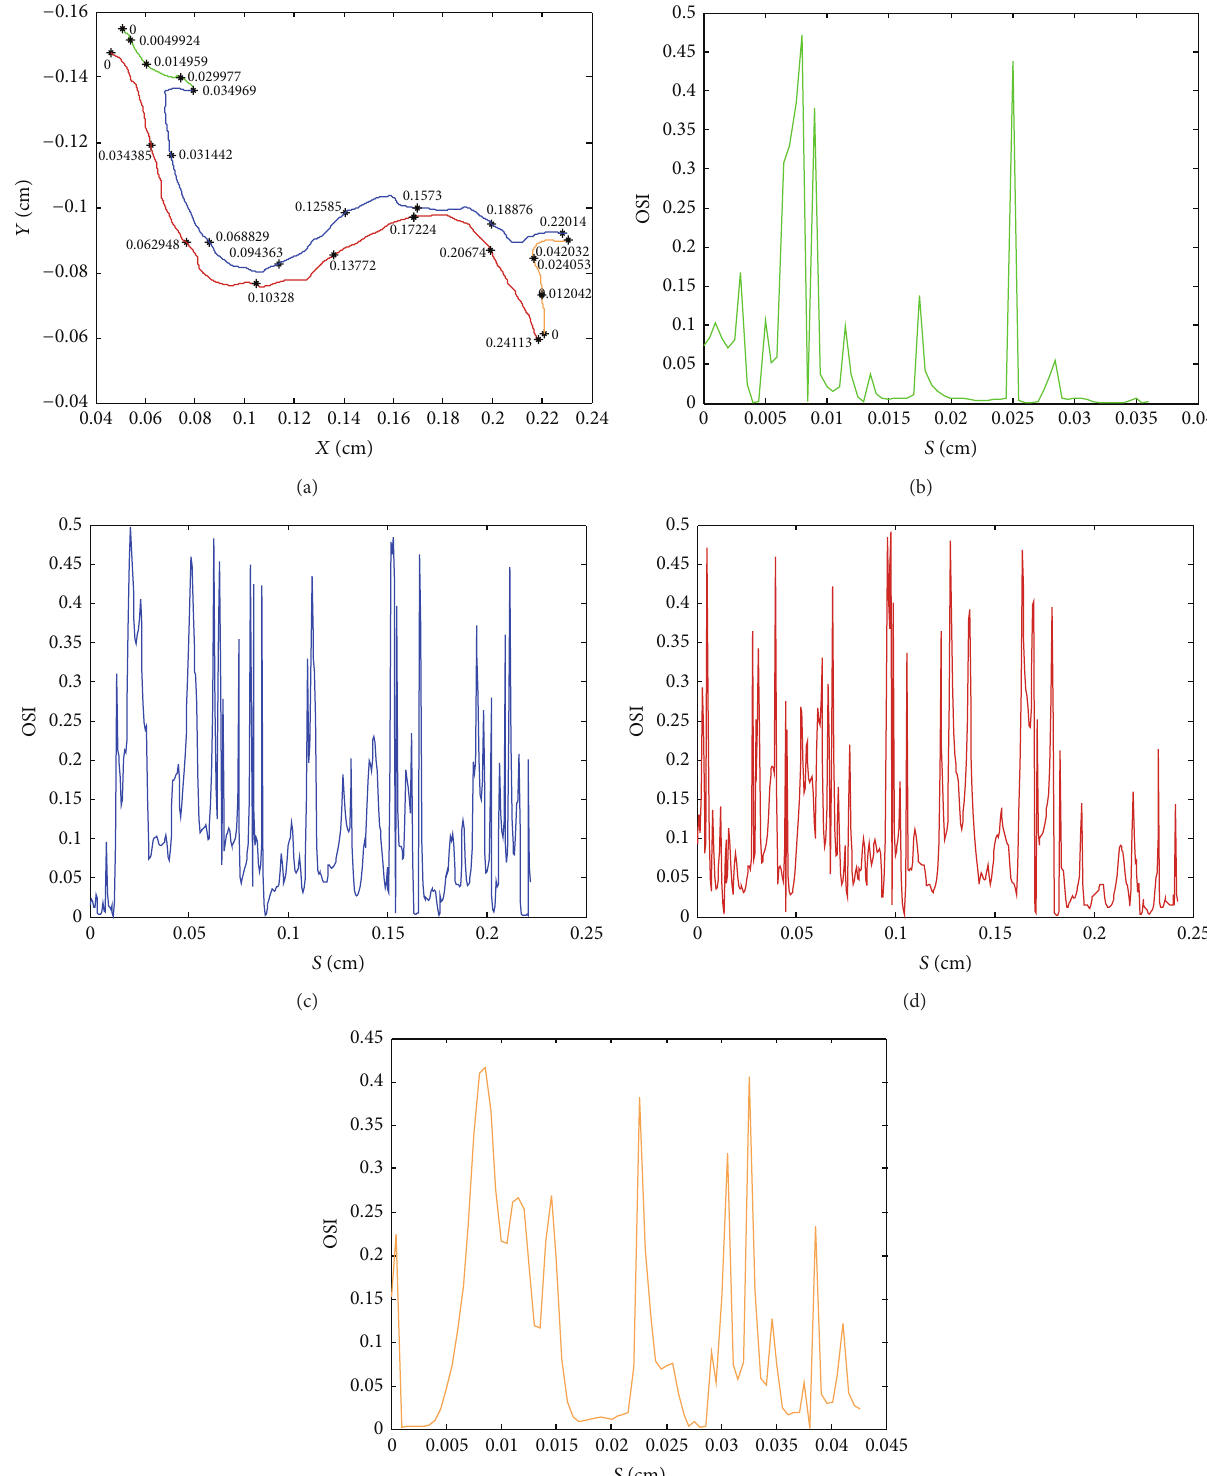
Figure8:(a)Boundaryplotsofcoronaryarterialwalls1,2,3,and4showninred,green,blue,andbrown,respectively.(b)–(e)OSIdistribution along coronary walls 1, 2, 3, and